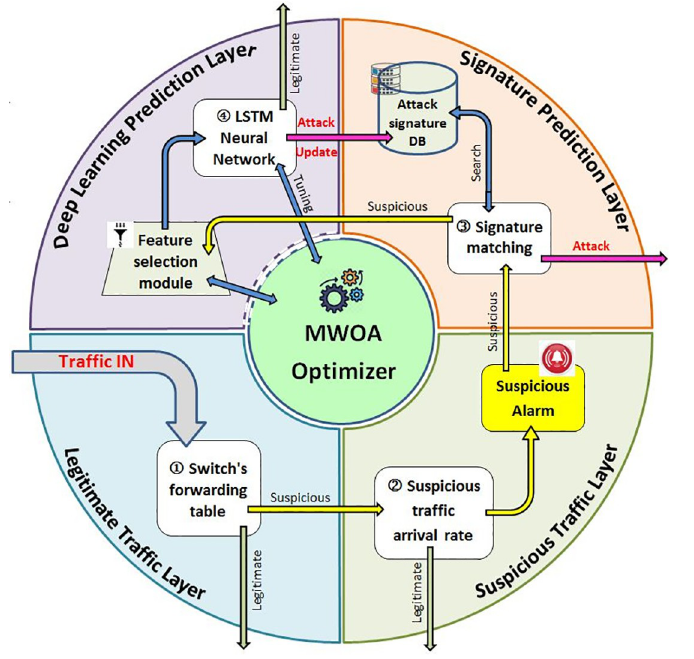
Fig 3. The proposed (HDLIP-IoT)